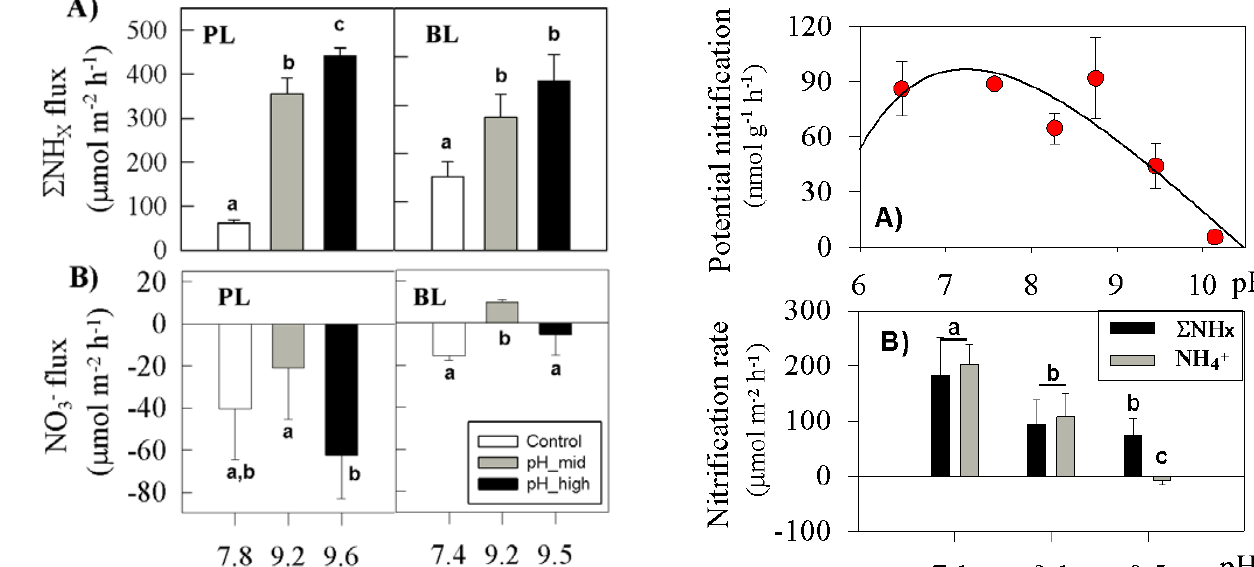
(black 4 F inhibitor at three pH levels of 6 3 4